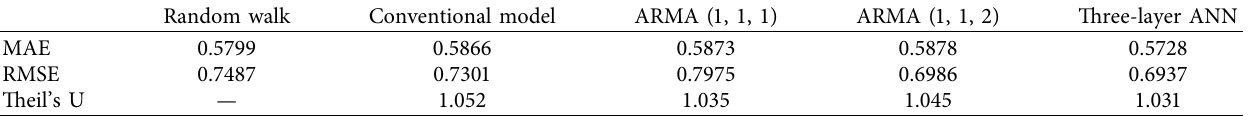
Table 5: Performance evaluation matrix of the models under consideration for wheat futures price series. Random walk